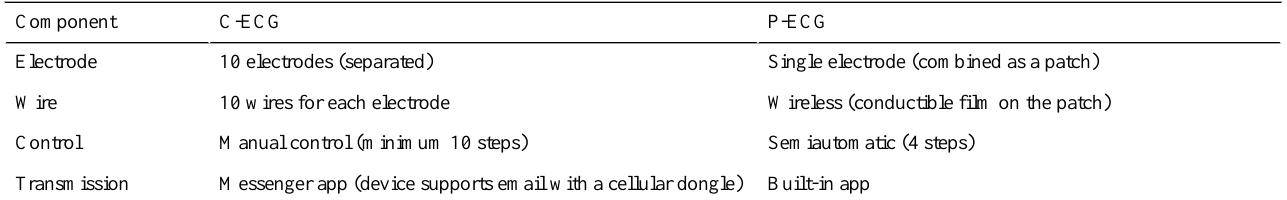
Table 1. Functional comparison between the conventional 12-lead electrocardiogram (C-ECG) and patchy-type wireless 12-lead electrocardiogram (P-ECG) devices. P-ECGC-ECGComponent